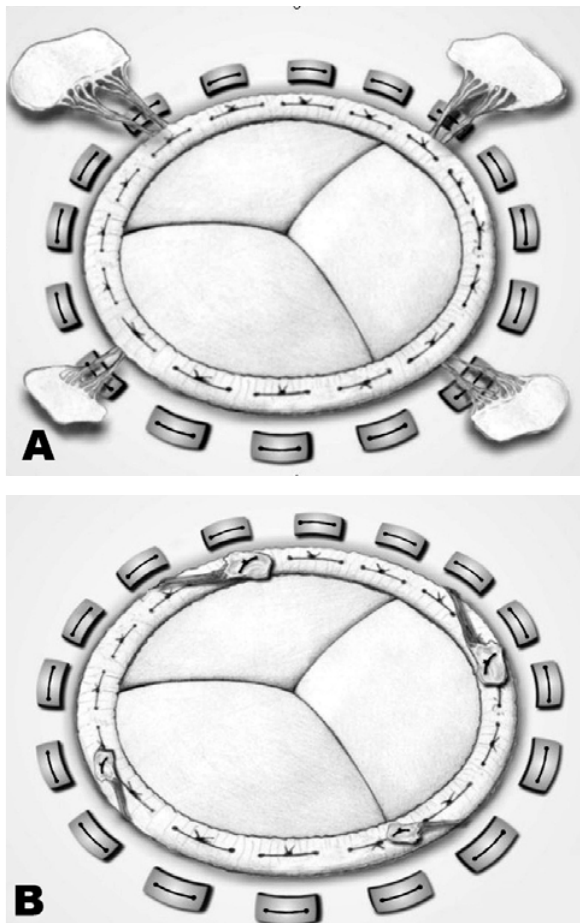
Fig. 2 - A: Bioprótese implantada com a tração papilar. B: Operação concluída, com a remoção do excesso de cordas